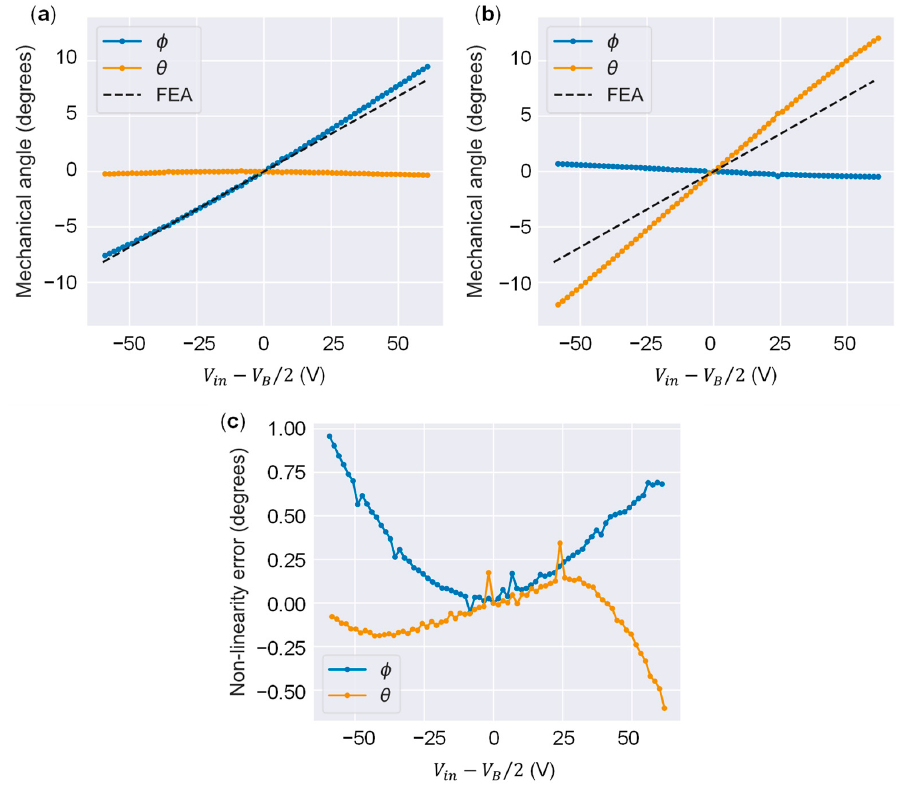
Figure 9. Voltage-angle characteristics: ( a ) x -axis and ( b ) y -axis actuations and ( c ) nonlinearity error.